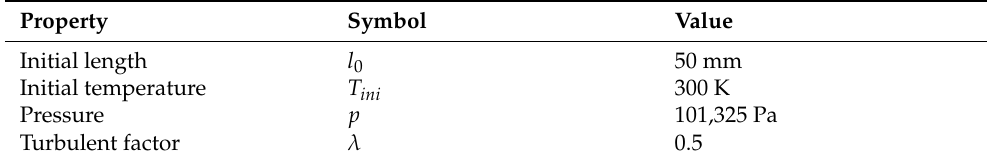
Table A1. Parameters for ablative